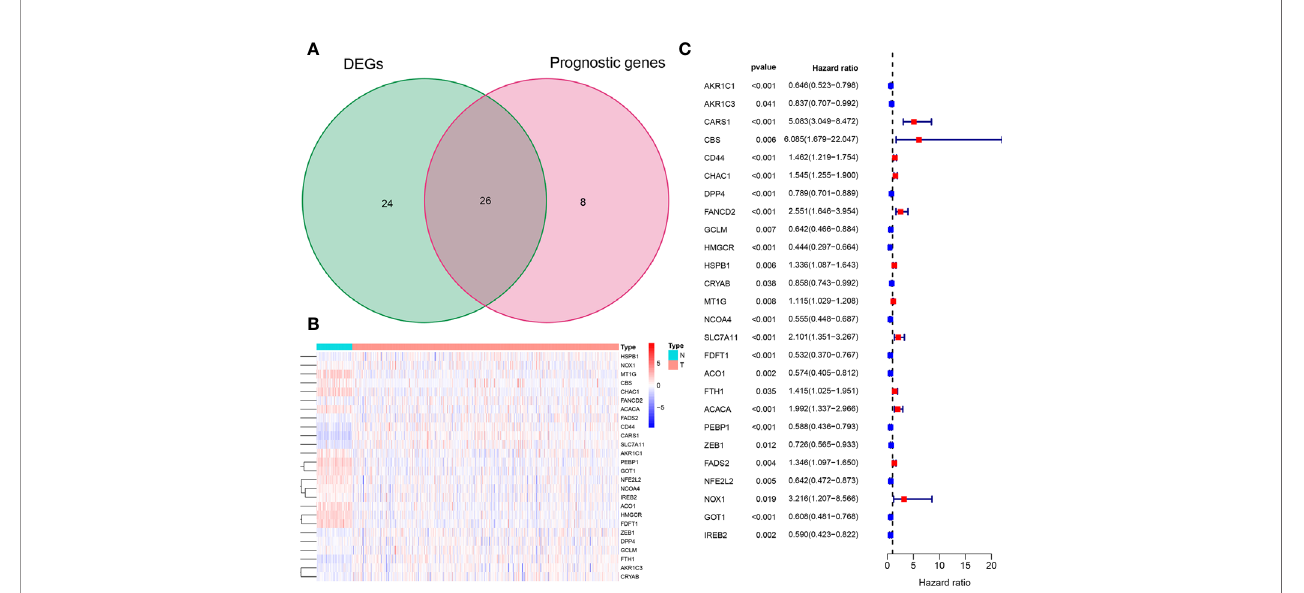
FIGURE 2 | Identi fi cation of 26 PDEFRGs. (A) Venn diagram showing 26 PDEFRGs between DEFRGs and prognostic genes. (B) The heat map of 26 PDEFRGs. (C) Forest plots showing that 26 PDEFRGs correlated with OS ( P <